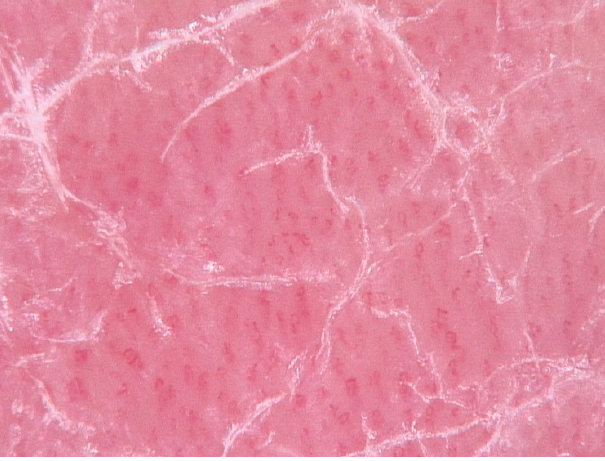
Figure 5. Dermoscopy of a typical psoriatic plaque showing the presence of dilated, elongated, bushy vessels which are homogeneously distributed on a reddish background.